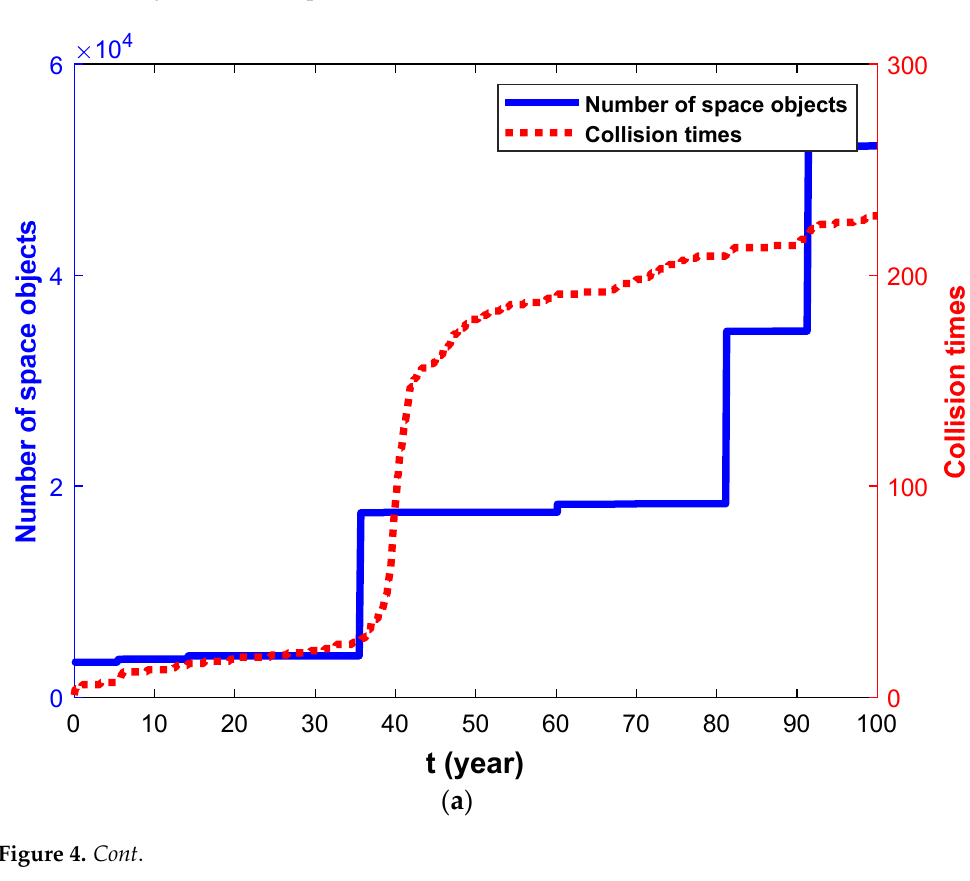
Figure 3. Twenty simulation experiments of scenario 2.